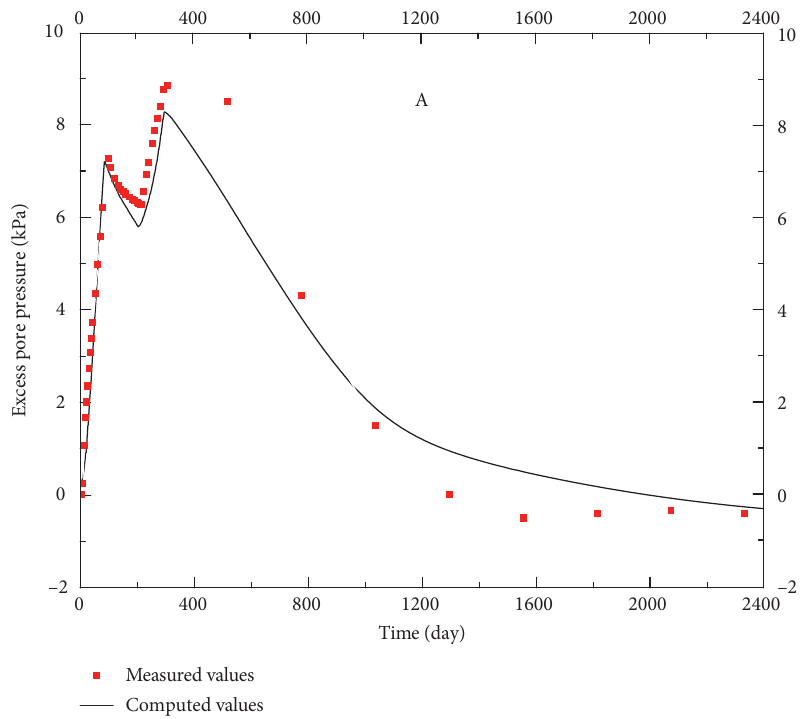
Figure 4: Measured and computed excess pore pressure at the base of the